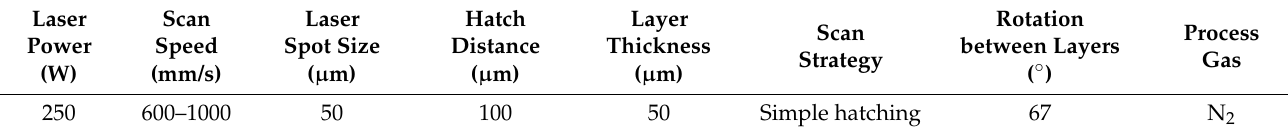
Table 4. PBF-LB process